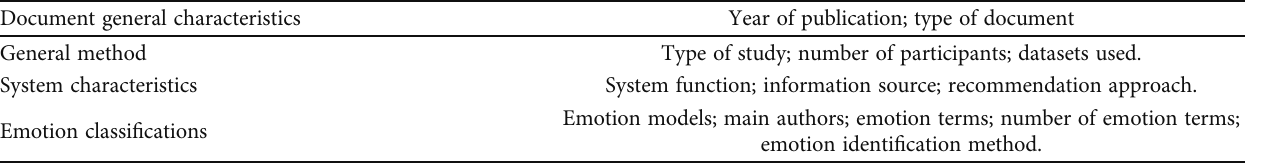
Figure 1: Flowchart of the Document Selection Process Table 2: Document Coding